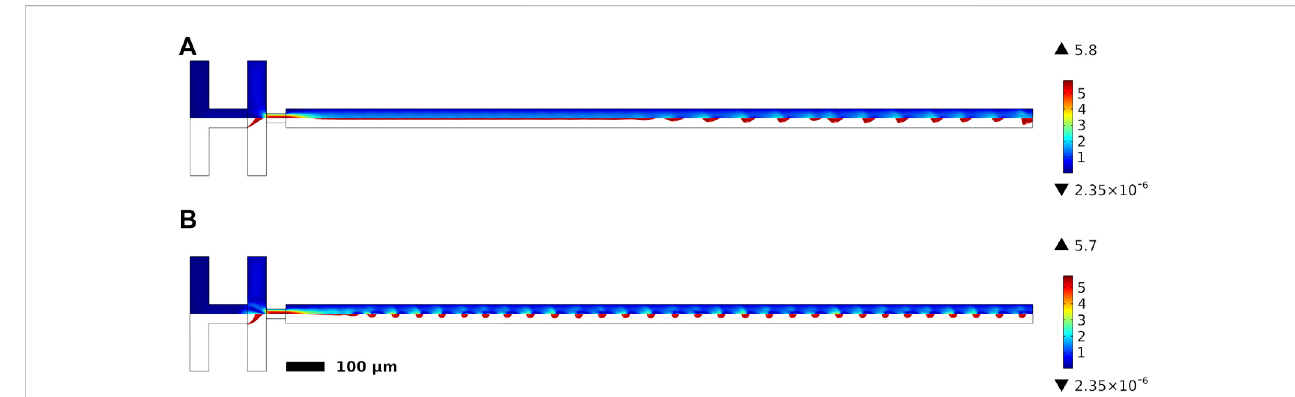
FIGURE 10 Velocity pro fi les for two simulations, the colour scale indicates the velocity in m/s. The bottom half of each pro fi le is an isosurface render showing the droplets generated. Velocity pro fi le of the (A) σ 0 = 25 mN/m simulation and (B) σ 0 = 118.75 mN/m with a 25 µm neck width.